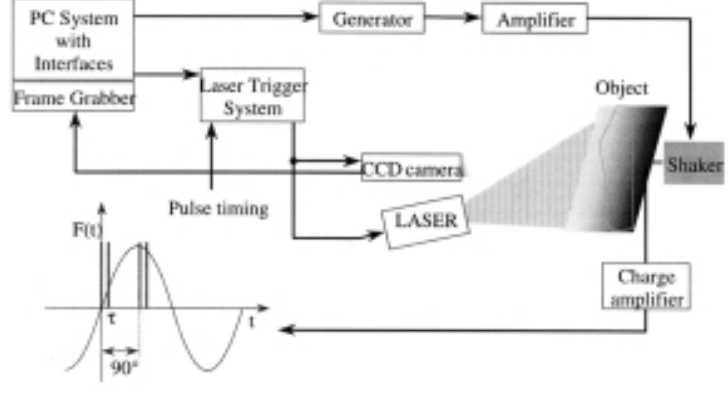
Fig. 1. Pulsed-laser ESPI set-up.